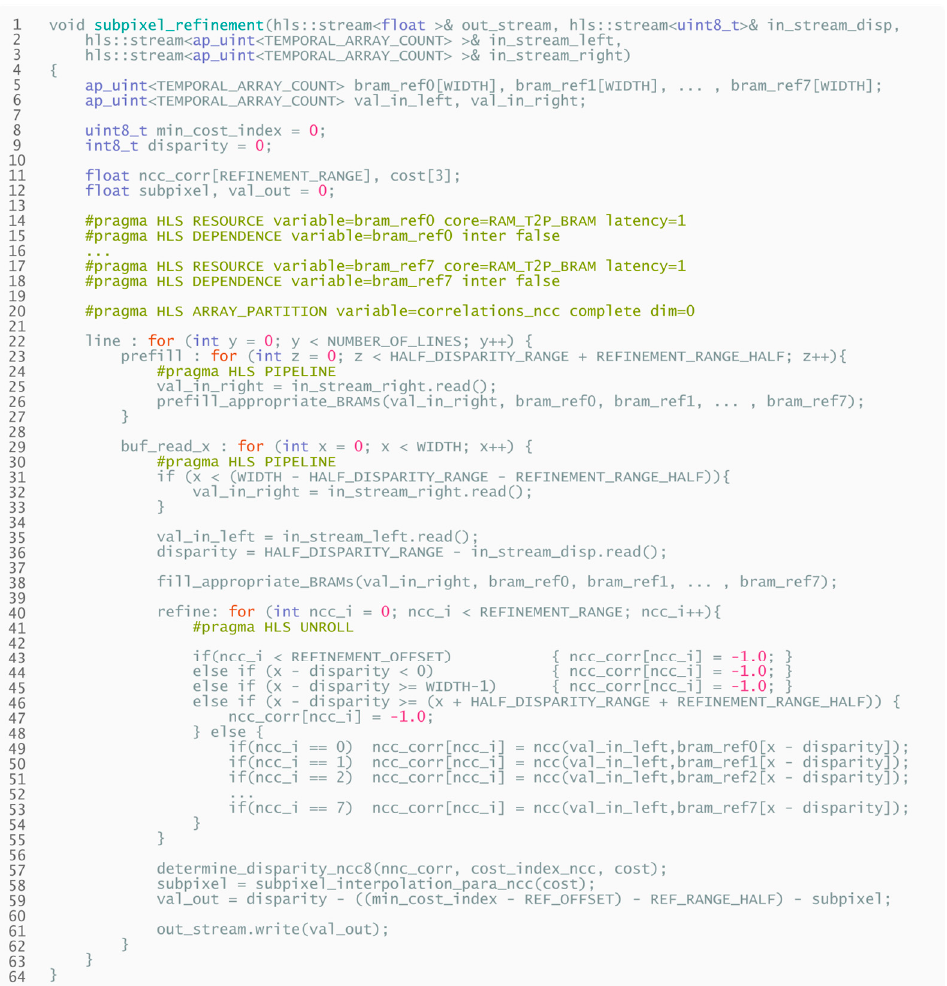
Listing 4. High-level pseudocode for subpixel refinement. Repetitive parts of the design are omitted to improve